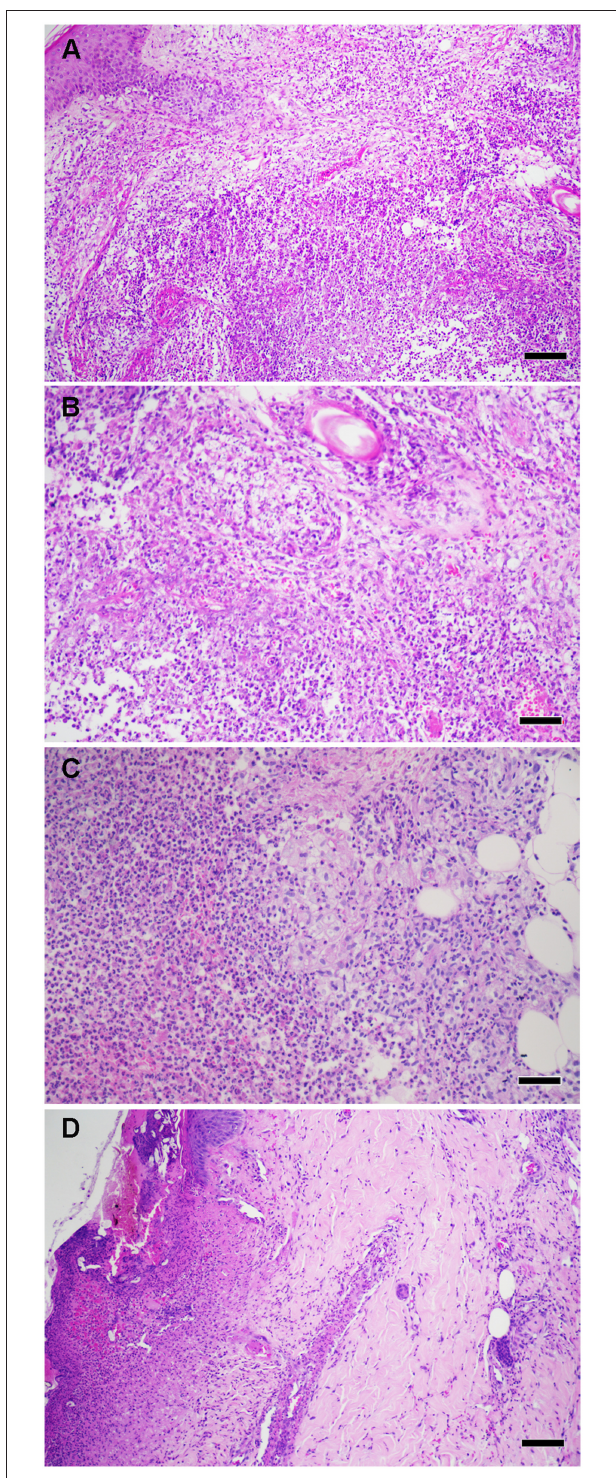
FIGURE 2 | (A) Histopathological aspects of ENL skin lesions. (B) High power showing foamy macrophages and neutrophil infiltrate. (C) High power showing a collection of neutrophils (microabscess) in deep dermis. (D) Necrotizing ENL, Epidermal ulceration with vasculitis. Hematoxylin and eosin staining (scale bars: 100 µ m). Images from Leprosy Laboratory